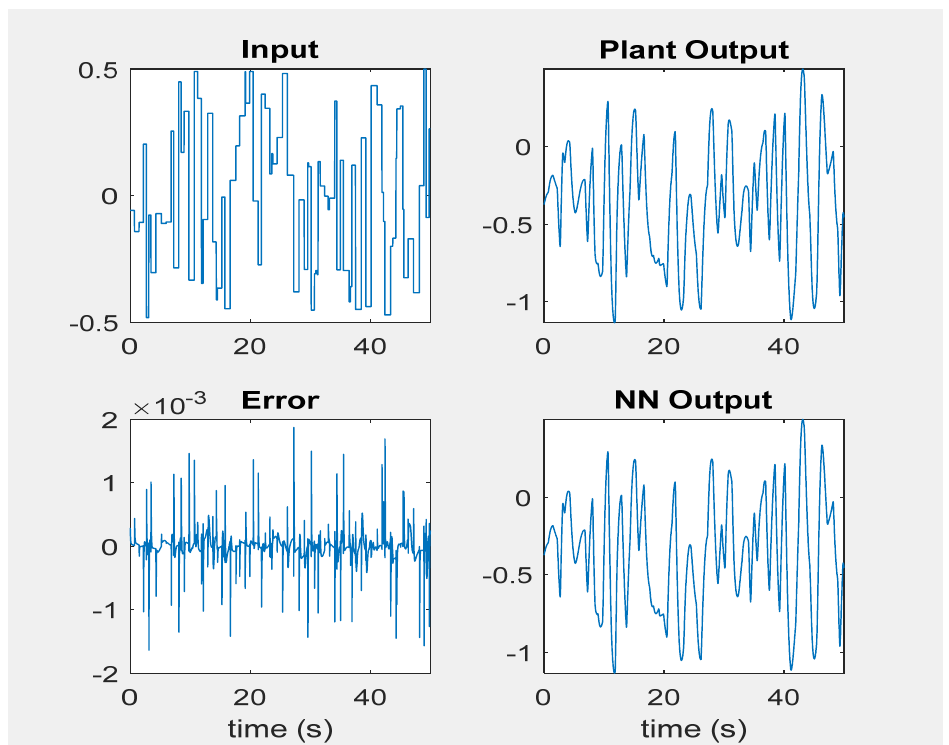
Figure 8. Training data of neural network.